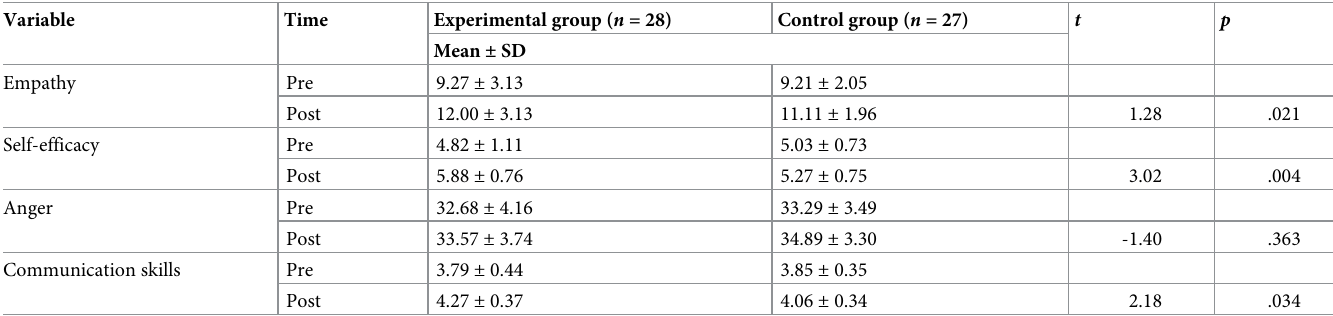
Table 3. Differences in the dependent variables between